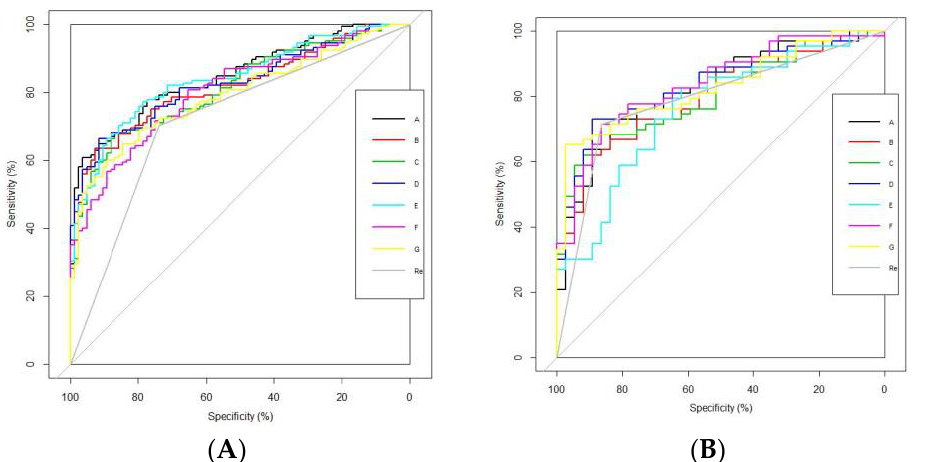
Figure 4. ROC curves of different models and readers. Note: ( A ) shows the ROC curves of different radiomics models and readers in the training cohort; Model A showed the highest AUC value. ( B ) shows the ROC curves of different radiomics models and readers in the validation cohort. A, CE-T1WI + T1WI + T2WI. B, CE-T1WI + T1WI. C, T2WI + T1WI. D, CE-T1WI + T2WI. E, CE-T1WI. F, T1WI. G, T2WI. Re, readers.